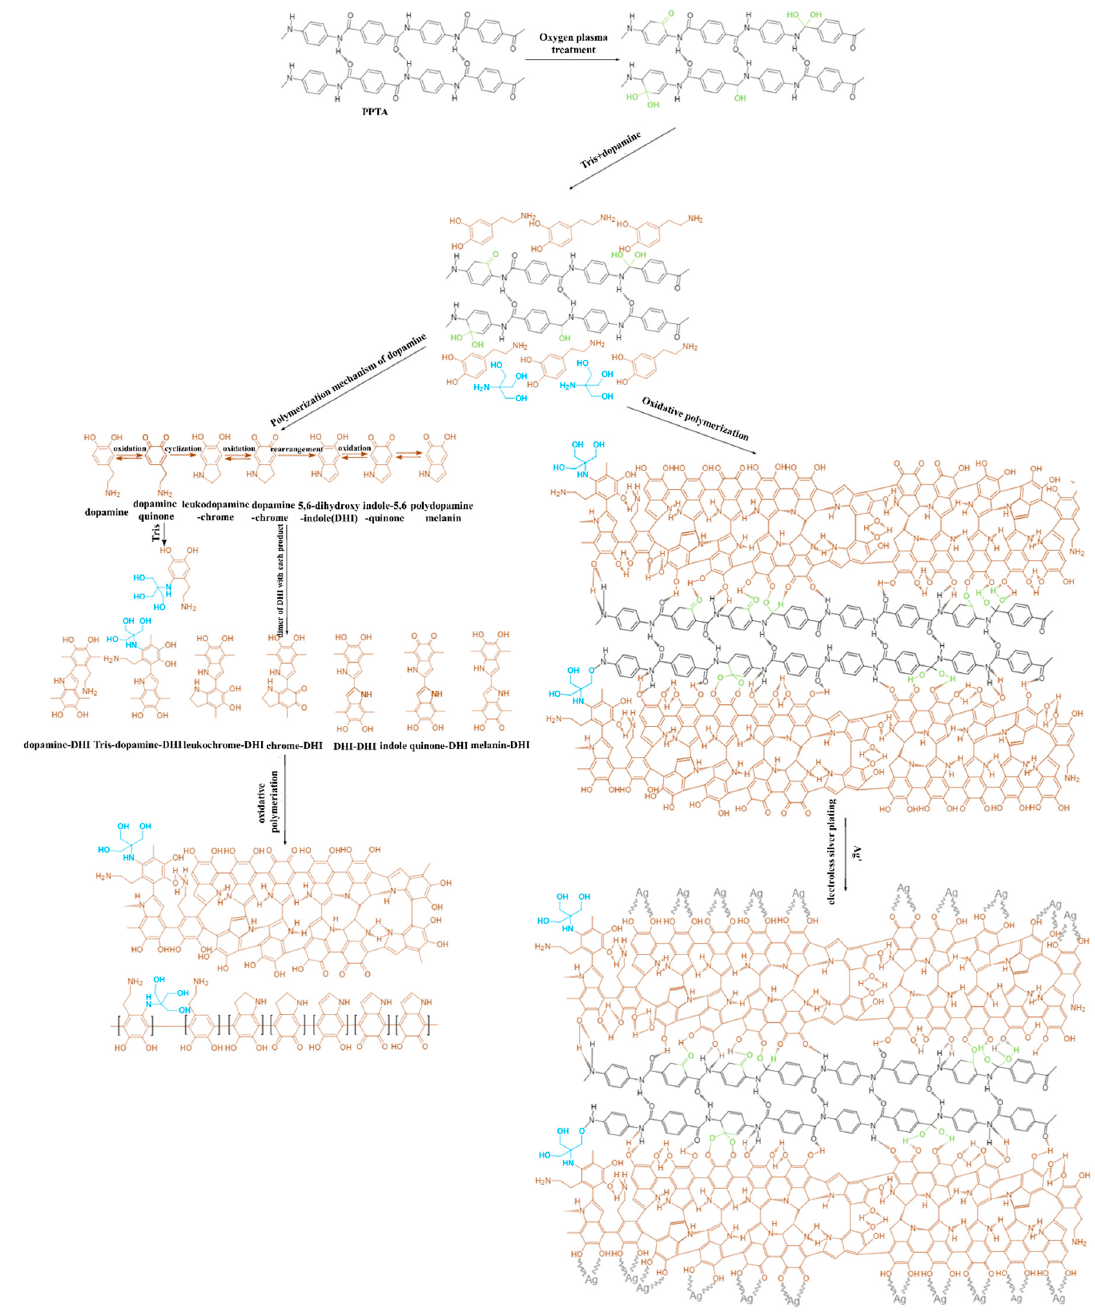
Figure 1. The possible mechanism of oxygen plasma treatment, dopamine modification and electroless silver plating [9,10,25,33,35,38]. silver plating